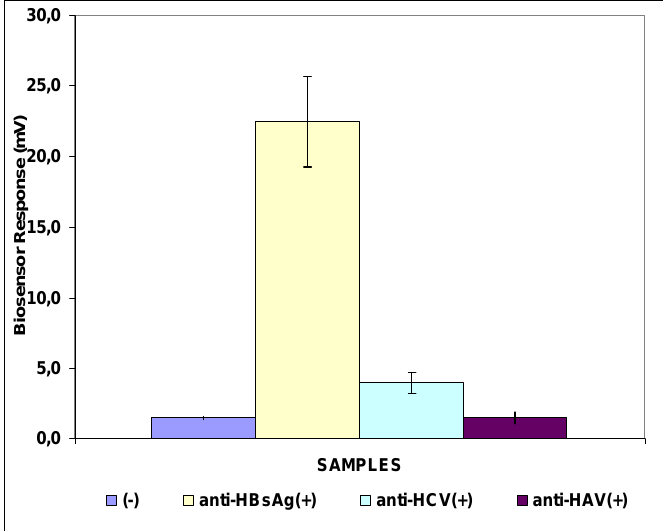
Figure 4. Biosensor response against the anti-HBs antibody. The sensor is based on Vero cells membrane-engineered with HBsAg. Sensor response is expressed as an associated change in the membrane potential of immobilized cells. Error bars represent standard errors of the average value of all replications with each sample ( n = 15 replications for each